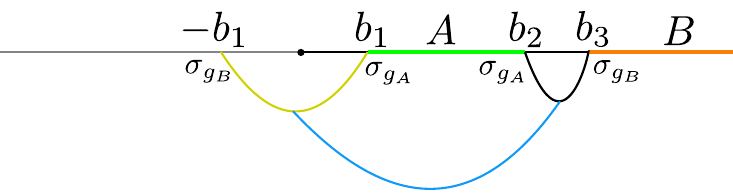
Figure 4. OPE channel corresponding to phase-II of the reflected entropy for two disjoint intervals.